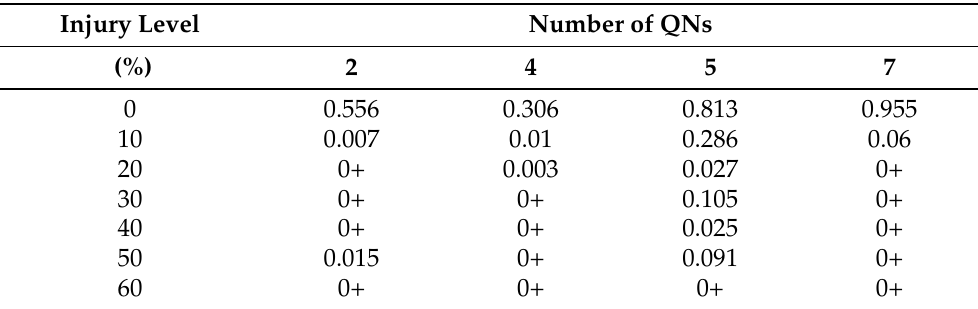
Table A7. P -values for normalized post-injury responses (see Figure 5A). p -values are with respect to adjacent (next lower) QN numbers. “0+” indicates p -value < 0.0005. N = 66 to 97 (mean = 79).